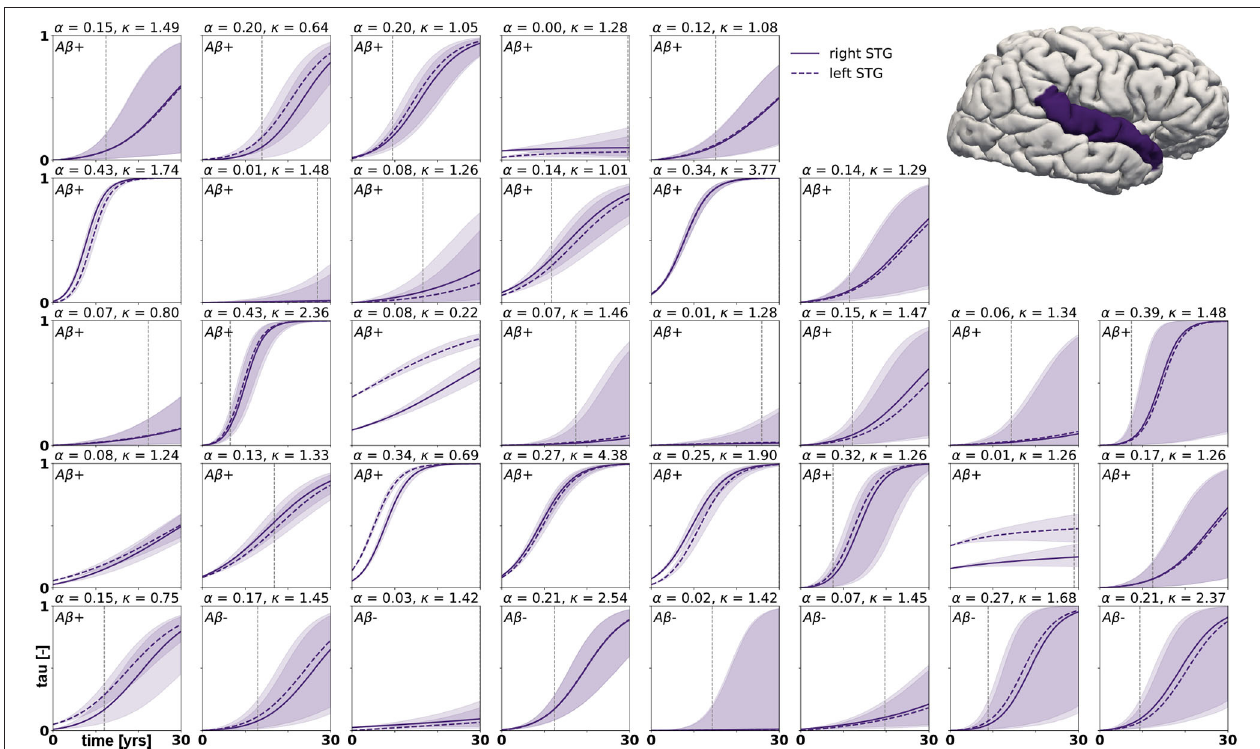
FIGURE 8 | Posterior predictive modeling. Predictions for the change in tau in the superior temporal gyrus in 30 years after first tau PET scan for 35 subjects. Shaded areas around the curves represent the 95% credible intervals of the